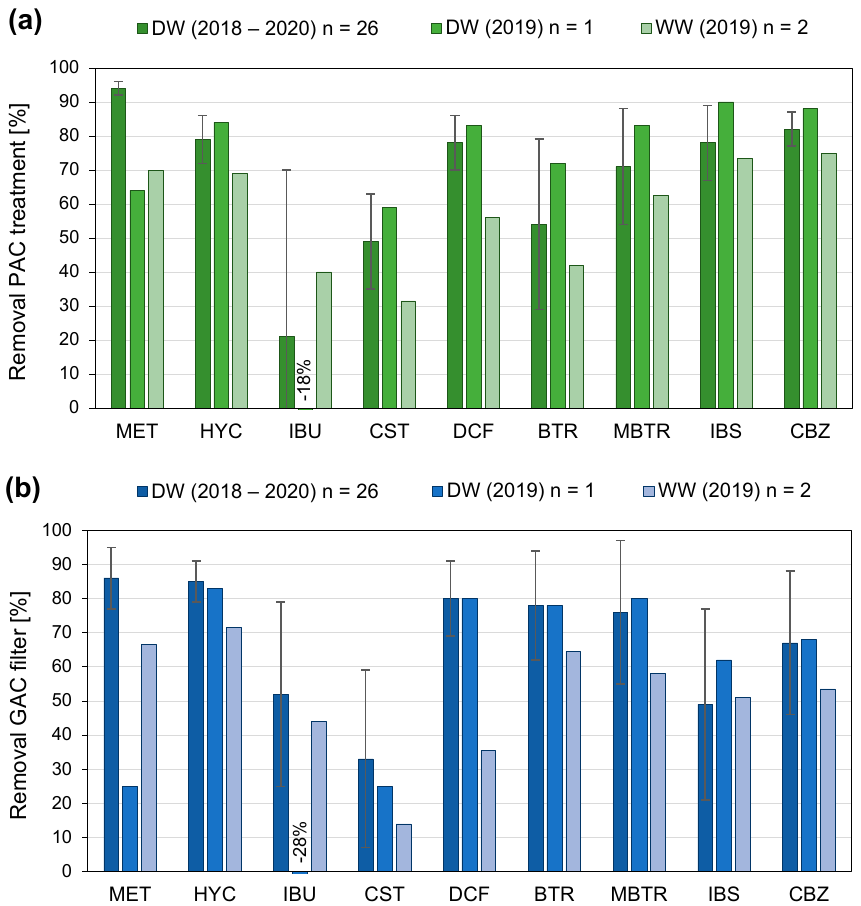
Figure 7. Mean OMP removal and standard deviation of nine regularly measured (n = 26) micropol- lutants at the WWTP compared to the removal of the measurement campaigns (DW, WW) for PAC treatment ( a ) and GAC filter ( b ). (SMX is not plotted in the figure because removal values were mostly negative. Considering the determination limit of 5 ng/L, negative removal values for IBU can be explained by measurement uncertainties. It is likely that measurement sensitivity reaches detection limits in the very low nanogram range.)